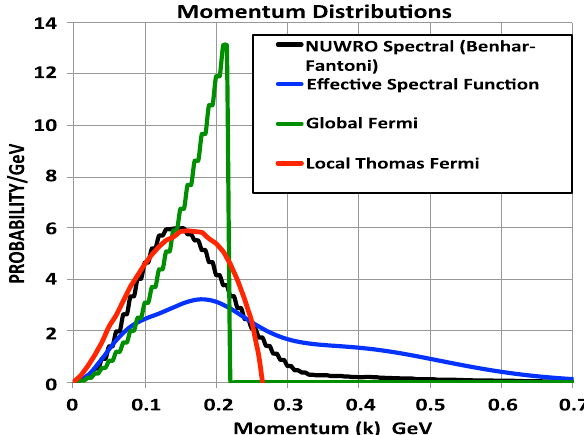
Fig. 1 One-dimensional nucleon momentum distributions in a 12 C nucleus. The green curve (Global Fermi) is the momentum distri- 6 bution for the relativistic Fermi gas (RFG) model. The red curve is the Local-Thomas–Fermi (LTM) gas distribution. The black curve is the projected momentum distribution of the Benhar–Fantoni two dimen- sional spectral function. The blue line is the momentum distribution for the effective spectral function model, which approximates the ψ (cid:2) super-